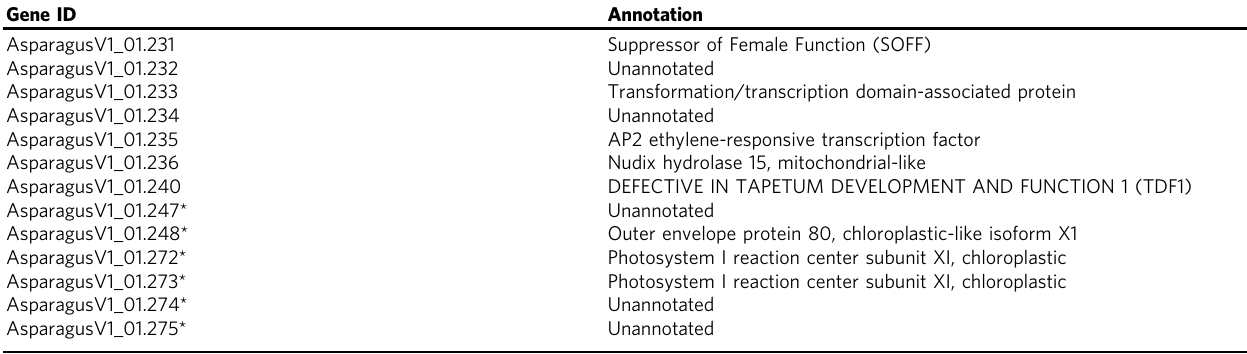
Table 1 Annotations of the 13 hemizygous non-recombining genes on the Y